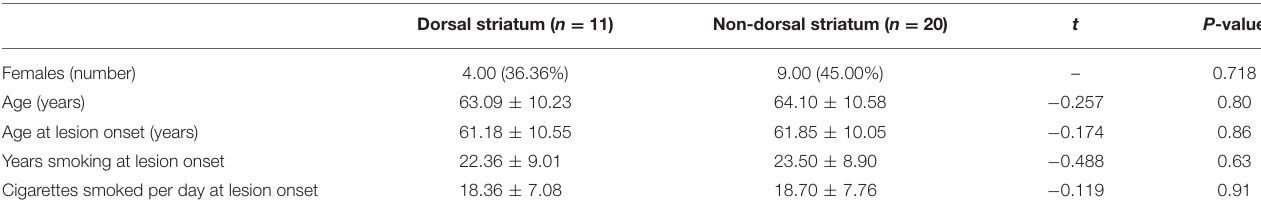
TABLE 2 | Characteristics of the dorsal striatum group and the non-dorsal striatum group. Dorsal striatum ( n =